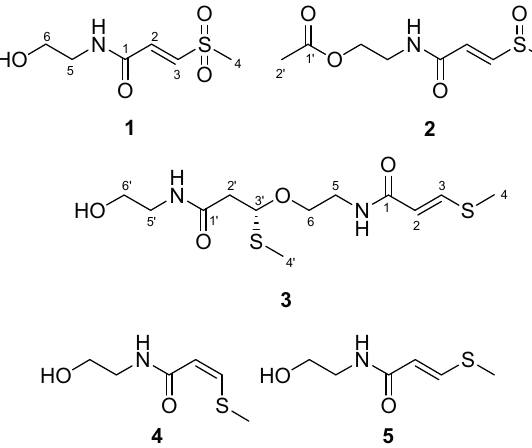
Figure 1. The structures of clinamides A-C ( 1 – 3 ), 2- cis -entadamide A ( 4 ), and entadamide A ( 5